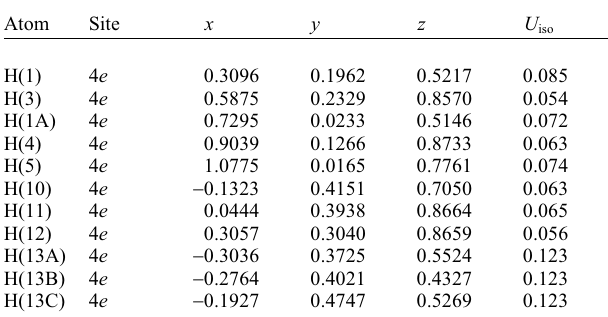
Table 2. Atomic coordinates and displacement parameters (in Å 2 )